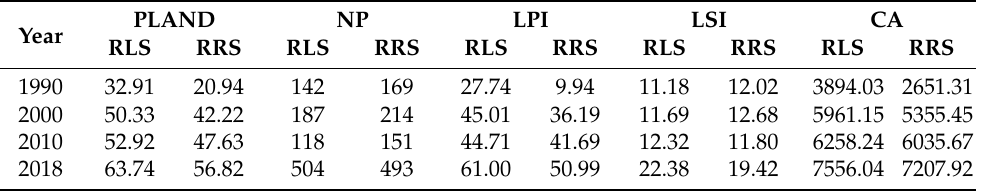
Table 12. Landscape metrics for built-up between the river’s left side and right